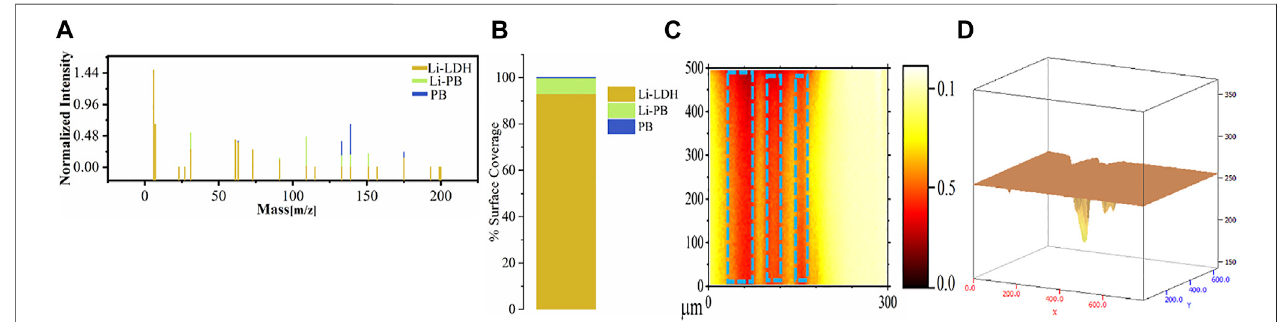
FIGURE 6 | Reference material data for ToF-SIMS analysis: (A) mass spectrum, (B) surface coverage, (C) ToF-SIMS, and (D) 3D image.